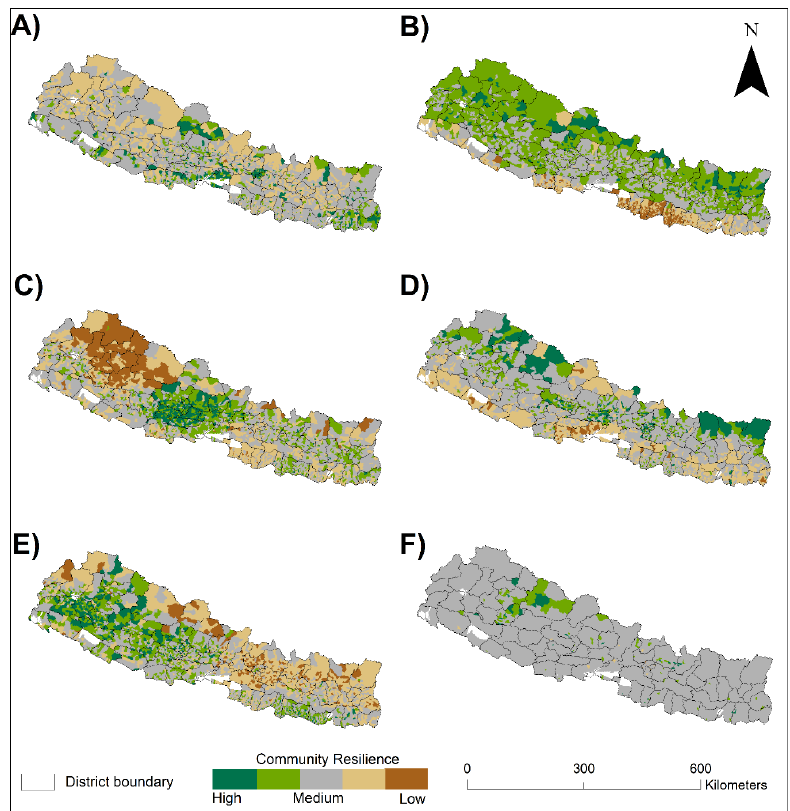
Figure 2. Geographic distribution of community disaster resilience index (CDRI) components: A) Infrastructure, B) Economic-Social, C) Community Capital, D) Environmental, E) Caste, and F) Migration.